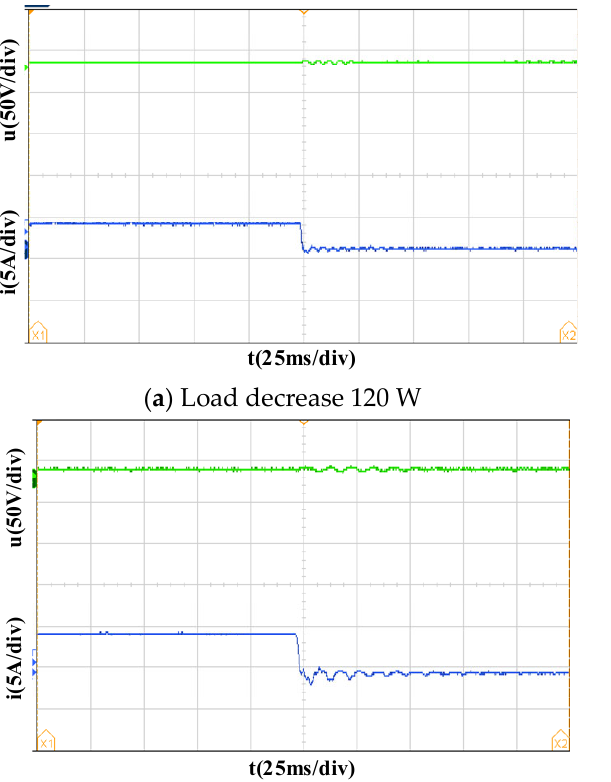
Figure 8. Experimental waveform under load suddenly increases, ( a ) Load increase 120 W, ( b ) Load increase 180 W, ( c ) Load increase 240 W, ( d ) Load increase 300 W. In Figure 8, the green curve is the DC bus voltage response waveform, and the blue curve is the battery current response waveform. In Figure 8a–d, the output current of the battery stabilizes at 2 A at the beginning, and rapidly increases to 4.4, 5.6, 6.6, 7.8 A after the load suddenly increases. The fluctuation range of DC bus voltage caused by the load suddenly increasing is about 4.9, 5.1, 5.2, 5.4 V. Figure 9 is response waveforms of the DC bus voltage and battery terminal current when the load suddenly decreases under different load conditions.